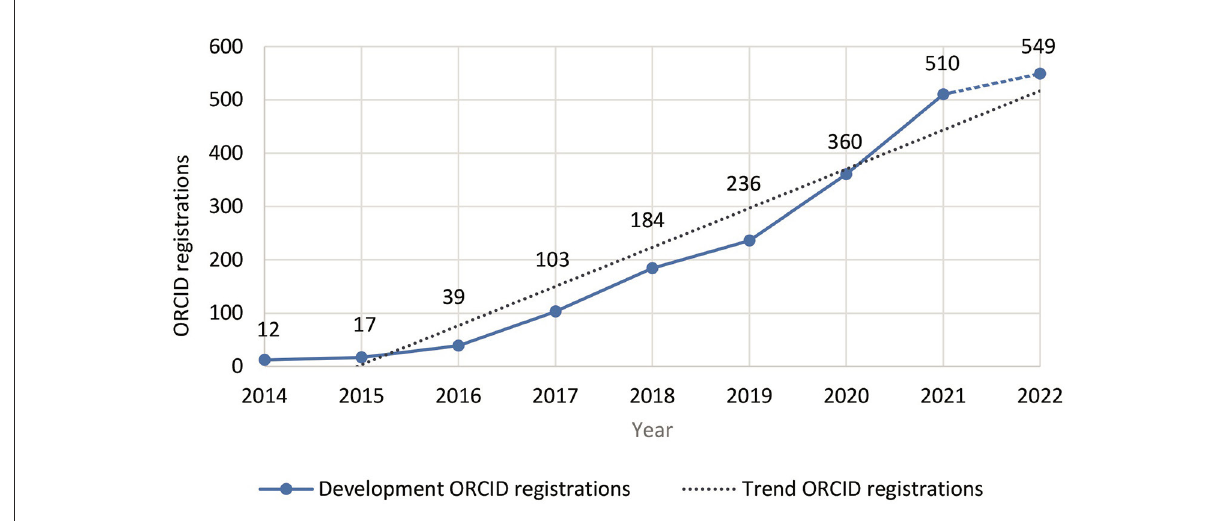
FIGURE4 Development of ORCID registrations for UOS employees (source: ORCID Member Portal, July